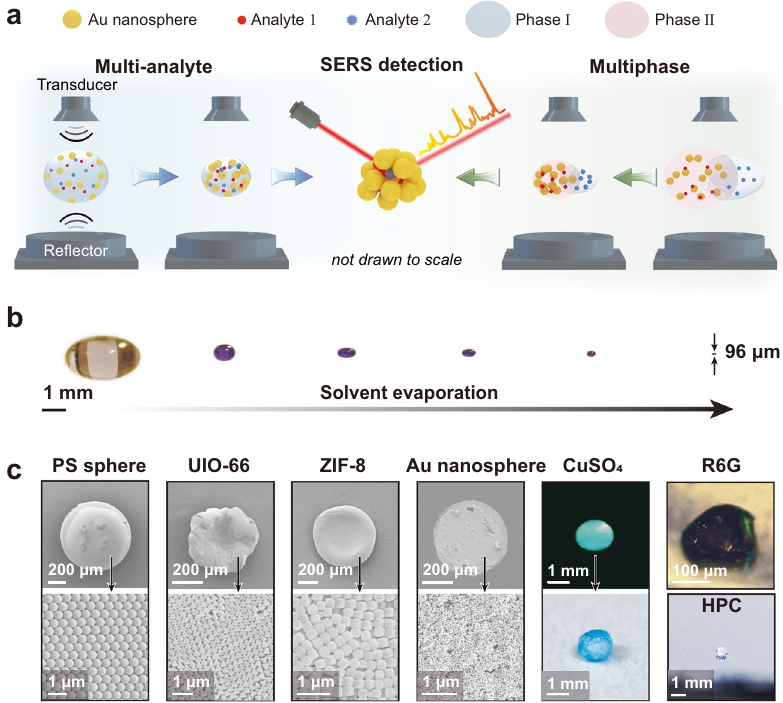
Fig. 1 | DLE platform enabled multiplex and multiphase SERS detection. a SchematicofthemultianalyteandmultiphaseenrichmentusingtheDLEplatform and the consequent multiplex and multiphase SERS detection. b Enrichment pro- cess of CV molecules from 10 µ L of ethanol solutions. c Aggregates concentrated